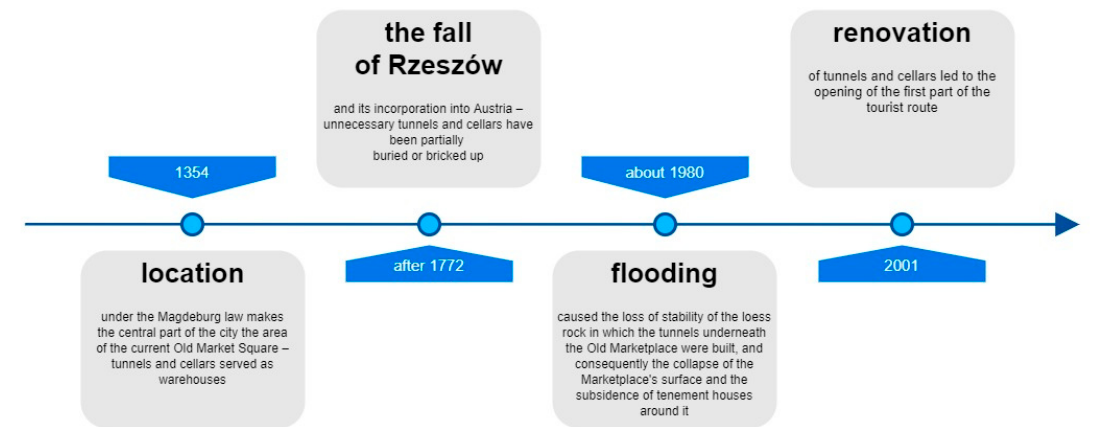
Figure 5. The history of the sites located under the Main Market Square in Rzeszów. Source: own study.